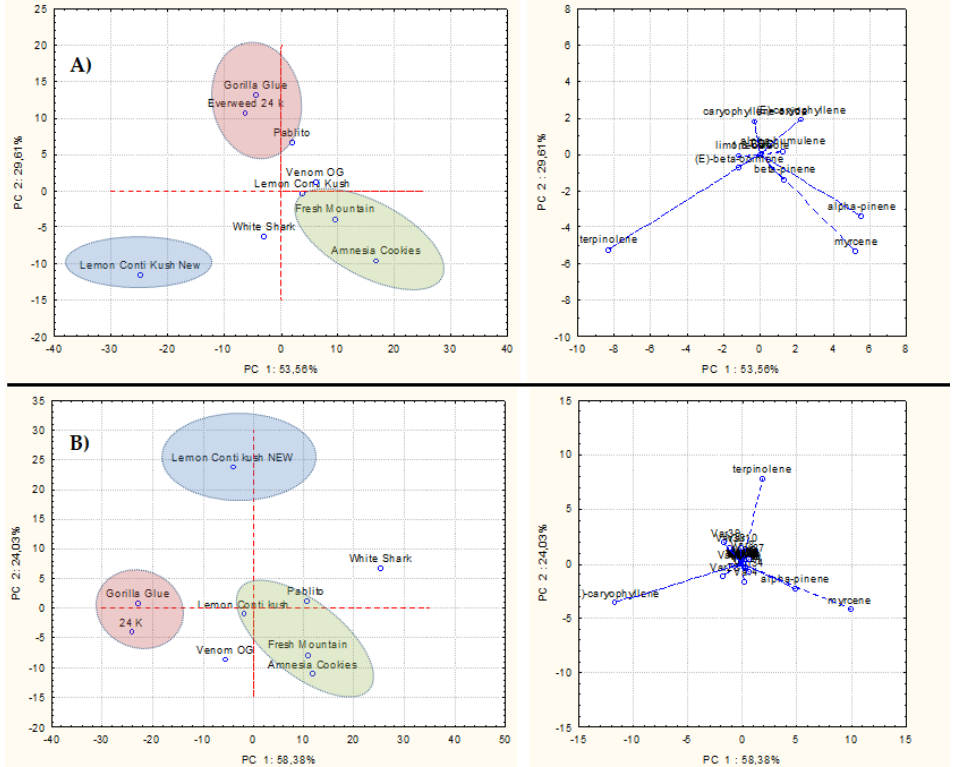
Figure 4. ( A ) Representation of PCA score and loading plots reporting hemp varieties and compo- nents found in the 9 EOs. ( B ) Representation of PCA score and loading plots depicting hemp varie- ties and volatiles extracted by